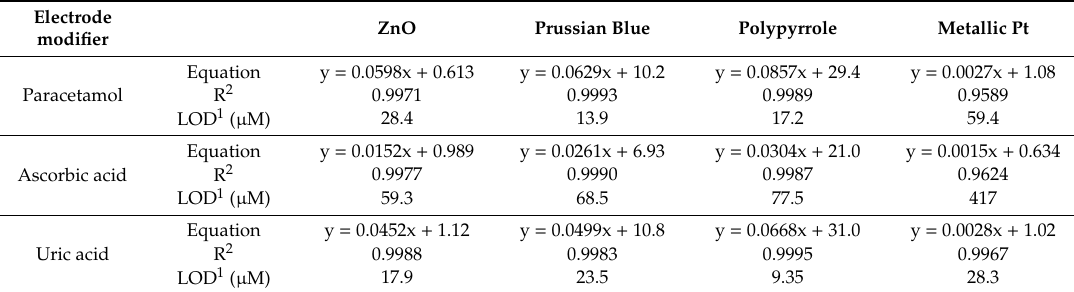
Table 1. Calibration data (y vs. x) for the individual calibrations of paracetamol, ascorbic acid, and uric acid employing the final sensors in the